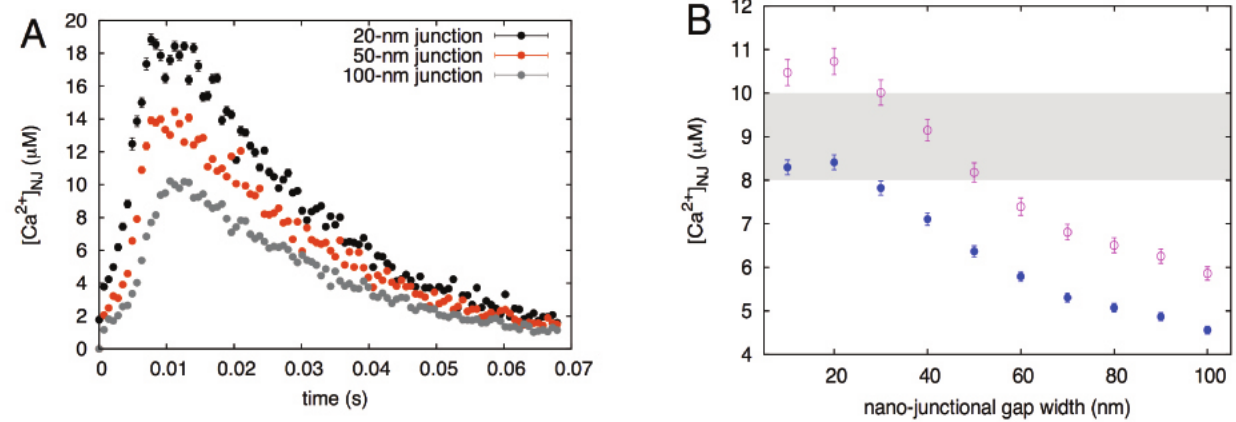
Figure 7. A , calculated nanojunctional [Ca 2+ ] transient, [Ca 2+ ] , “measured” inside the volume of the recreated L-SR nanojunction shown in NJ Figure 5. To show the effect of changes in the junctional geometry, we report three transients calculated using different junctional widths of 20, 50 and 100 nm. B , [Ca 2+ ] vs width of junction, concentration values are temporal averages of the transients as in panel A , calculated NJ over an interval of 0.065 s (solid circles) and 0.046 s (empty circles); see text for explanation. The shaded area indicates the approximate threshold values for CICR at RyR3s 58